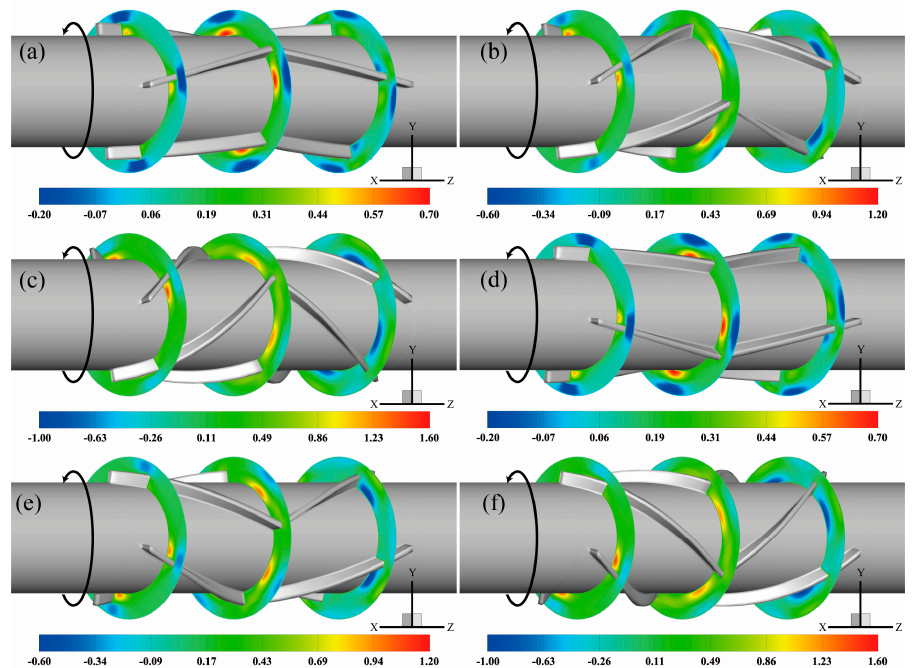
Figure 15. Tangential velocity contours with different helical angles for V-shaped blade at 120 rpm: ( a ) α = 10°; ( b ) α = 20°; ( c ) α = 30°; ( d ) α = − 10°; ( e ) α = − 20°; and, ( f ) α = − 30°.